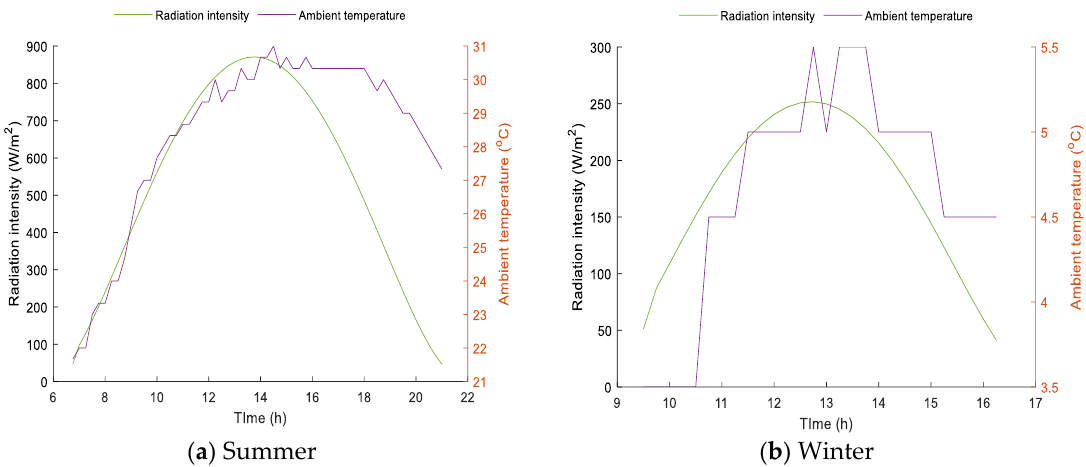
Figure 5. Radiation intensity and ambient temperatures with time: ( a ) Summer and ( b ) winter.